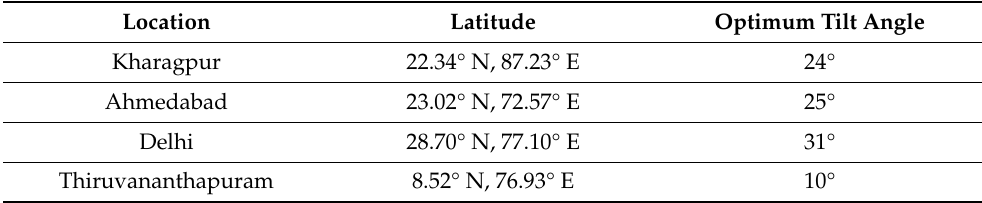
Table 1. The optimum tilt angles for different locations.